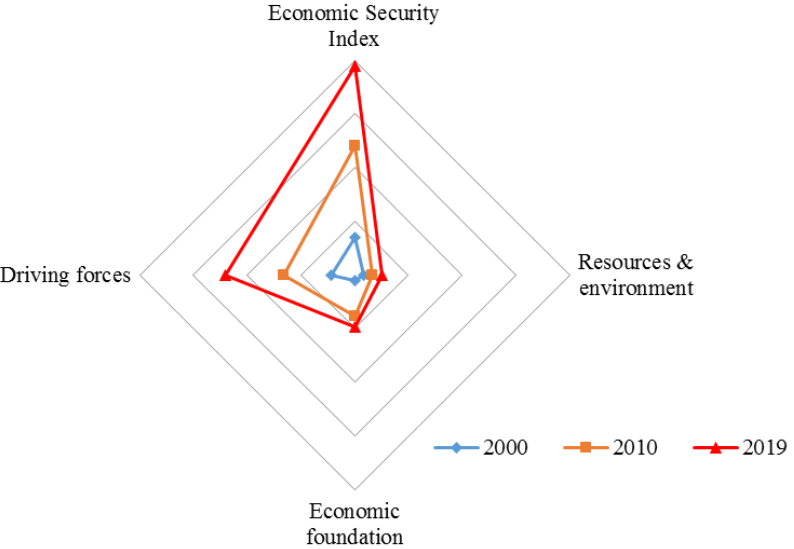
Figure 5. Radar Chart of Economic Security Index and Fractal Dimension Indexes of Qinghai–Tibet Plateau.